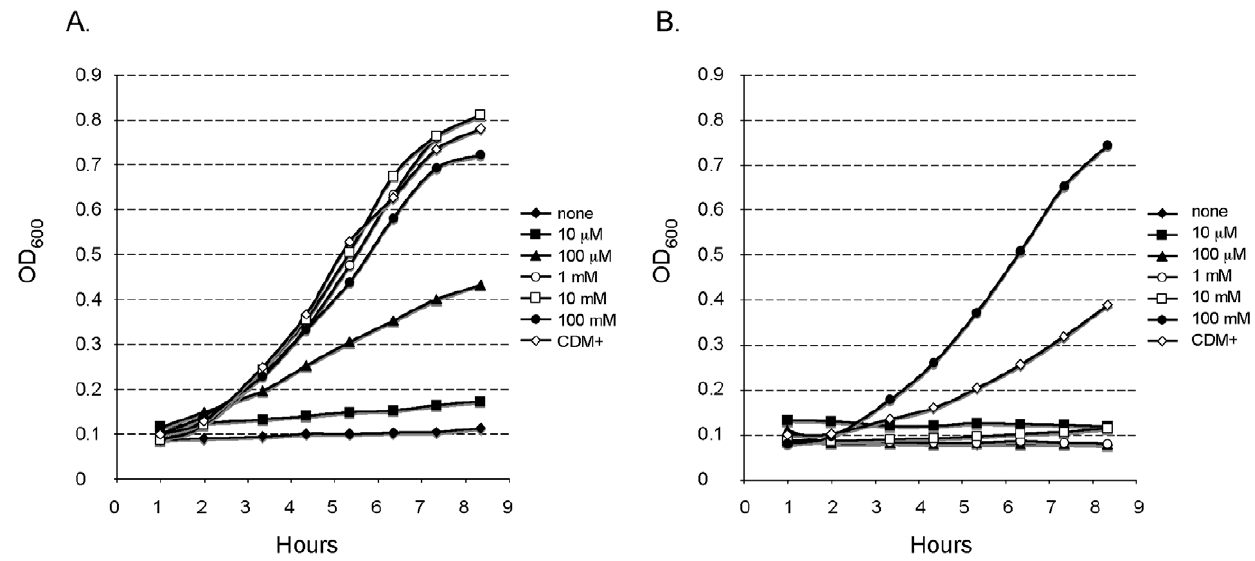
Figure 3. Growth properties of the trkH mutant in chemically definded medium. LVS (A) and trkH (B) were grown in chemically defined medium (CDM + ) or in CDMx buffered with sodium phosphate and supplemented with KCl as potassium source (at concentrations indicated in legend).